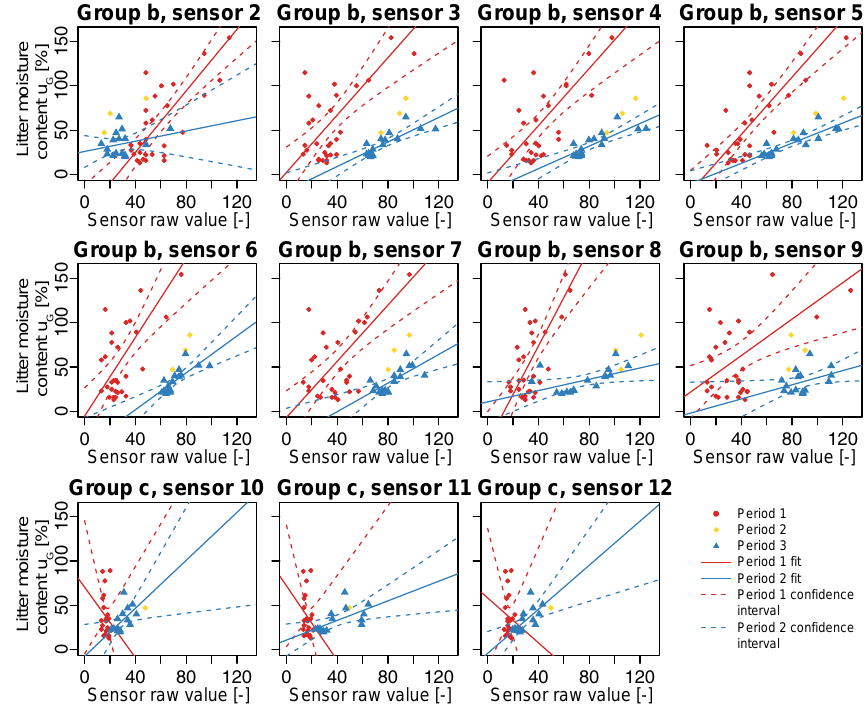
Figure 7. Linear regressions and associated confidence intervals calculated for periods 1 and 3 for each individual sensor of groups b and c, respectively. Yellow diamonds: sensor and litter moisture values during period 2. Group b: two-rod permittivity sensors, sensors 2–9; group c: sensors 10–12, electrical resistance. For basic statistics regarding the periods and regression parameters, cf. Tables 1 and 2,